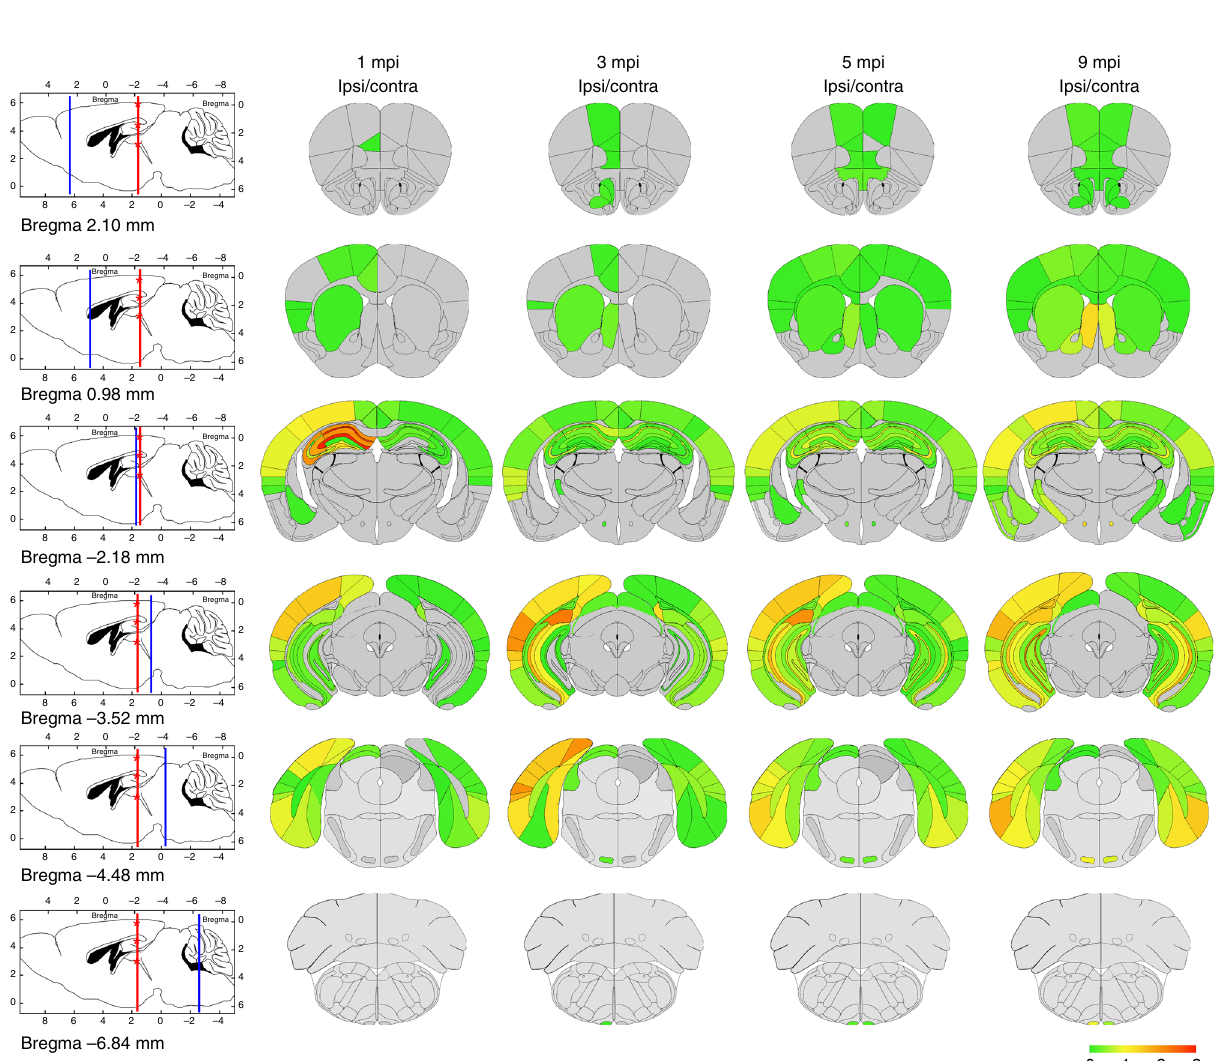
Fig. 4 Heat maps show time-dependent spreading pattern of TDP-43 pathology. Heat maps show the distribution and burden of TDP-43 pathology in neurons and in white matter tracts in the brains of CamKIIa-hTDP-43 NLSm mice at different post-injection times (1, 3, 5, and 9 mpi) in ipsilateral (Ipsi) and contralateral (Contra) sides. The panels in the far left column illustrate sagittal views of the corresponding coronal planes (blue line) and three sites of the injection into cortex, hippocampus, and thalamus (red asterisks). Each panel represents a coronal plane (Bregma; 2.10 mm, 0.98 mm, − 2.18 mm, − 3.52 mm, − 4.48 mm, and − 6.84 mm) for the different post-injection times. The burden of TDP-43 pathology was graded from negative (0, gray) to most abundant (3, red) and color-coded (scale bar) in the six representative coronal sections illustrated here depicting rostral to causal brain regions. Heat maps represent the mean values of the grades TDP-43 pathology from n = 3 mice at 1 mpi, n = 2 mice at 3 mpi, n = 3 mice at 5 mpi, and n = 3 mice at 9 mpi promoter, it is not surprising to fi nd predominantly neuronal TDP-43 pathology in this model.